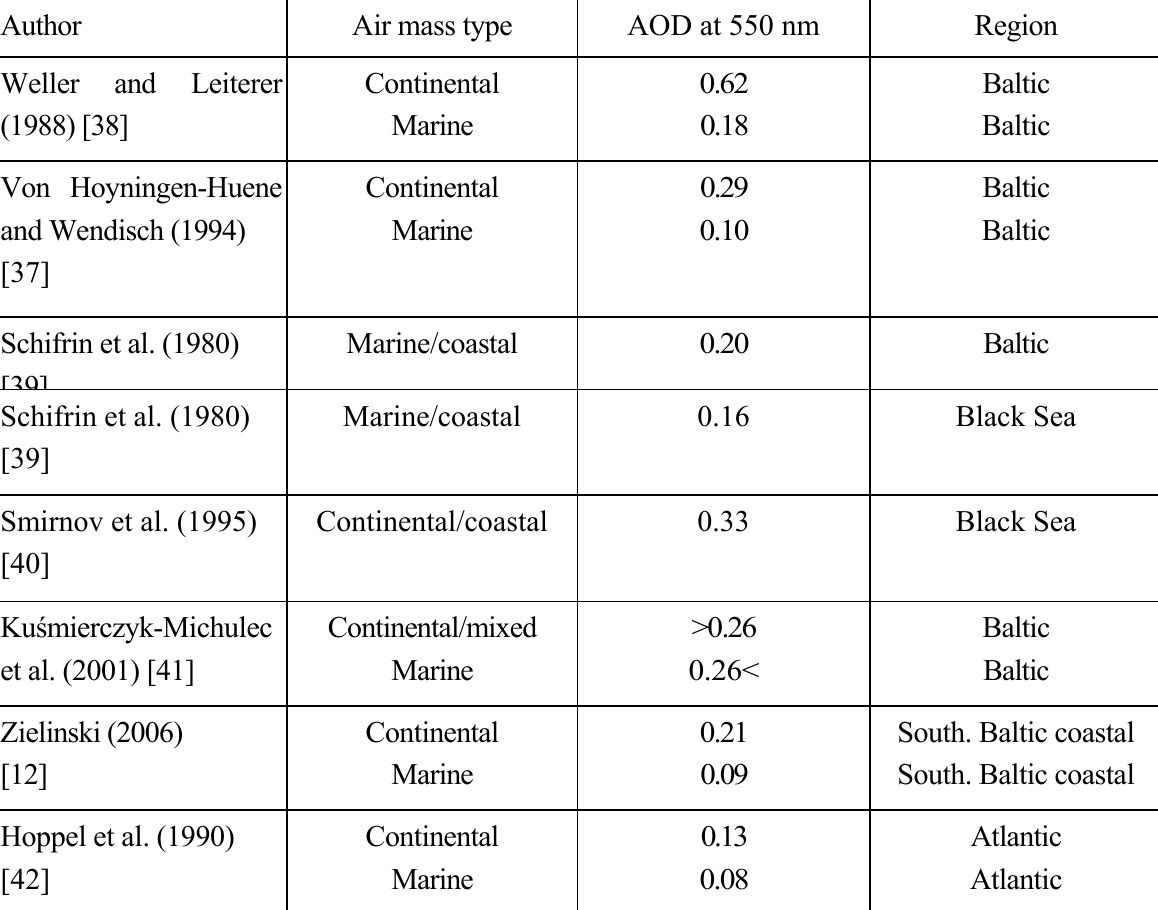
Table 8. AOD levels at 550 nm obtained by the authors for the southern Baltic stations, in Duck, NC and over the Greenland Sea. The authors’ data were obtained at 8 m/s and recalculated to